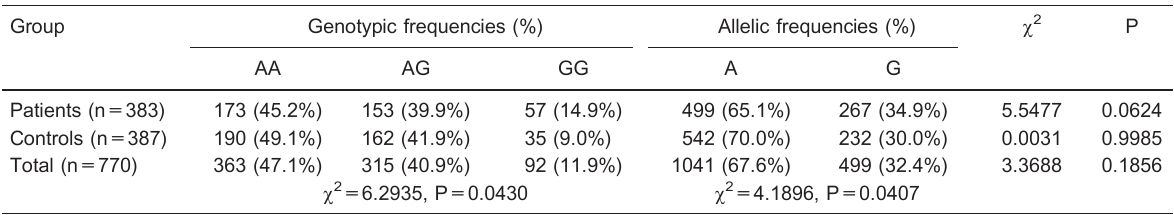
Table 2. Genotypic and allelic frequencies of the c.910A . G genetic variant of the XRCC1 gene in patients with esophageal cancer and cancer-free controls.